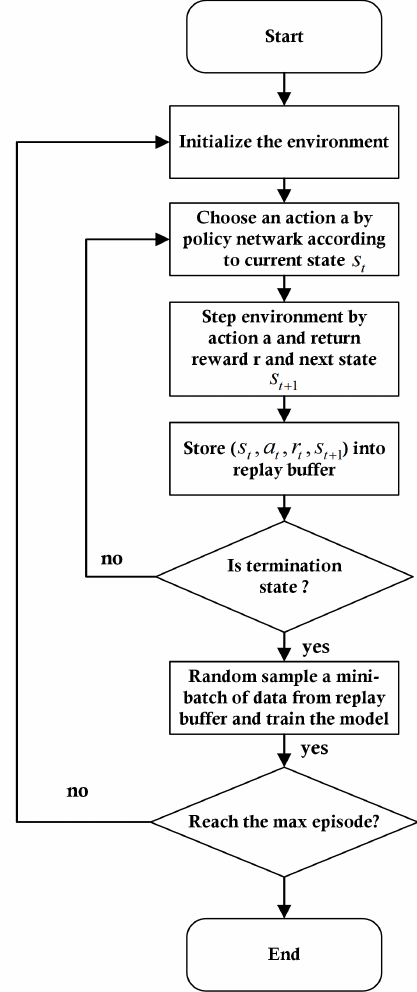
Figure 6. Flow chart of the planning